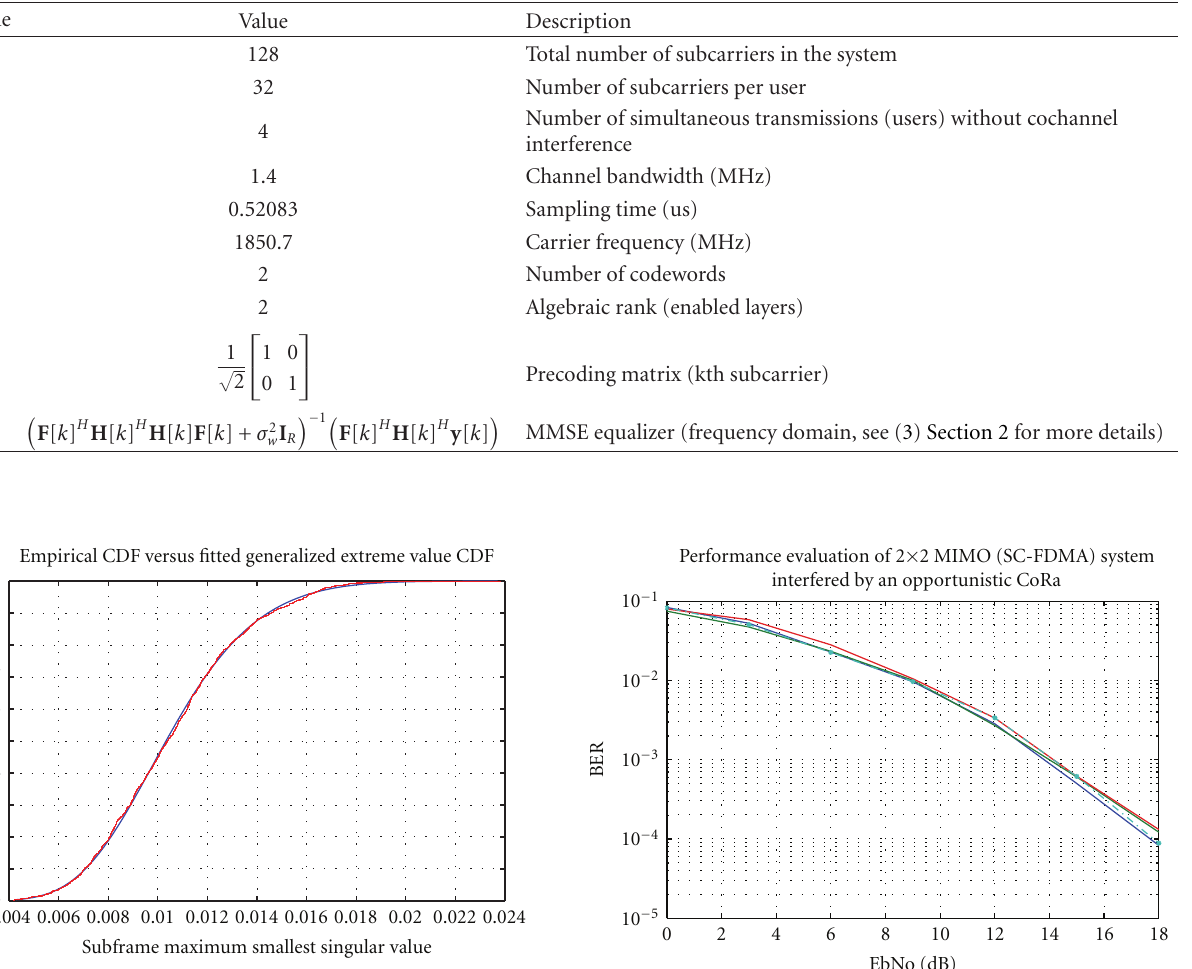
Figure 3: Fitted CDF of the largest singular values on a per subframe basis.